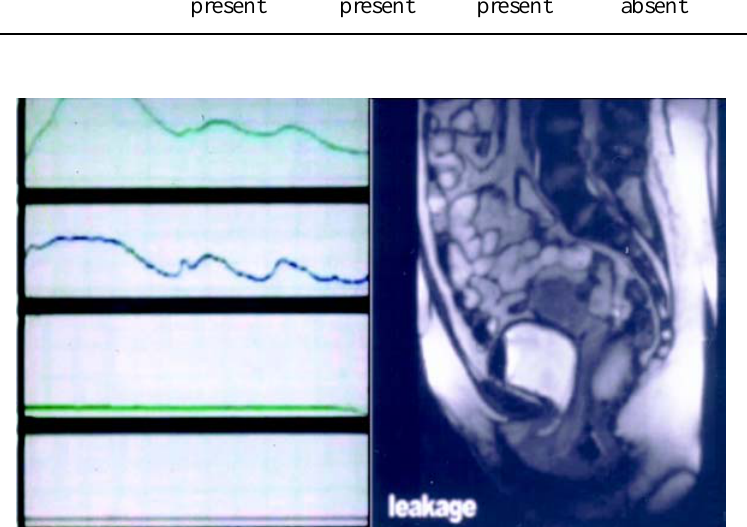
Figure 2 – Magnetic resonance imaging video urodynamics. Urodynamic parameters during Valsalva maneuvers concomitant to magnetic resonance image of the pelvis showing descent of the bladder neck below the pucococcygeal line and the urethra fully opened, allowing loss of urine.